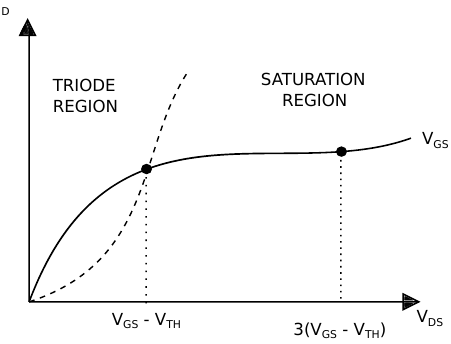
Figure 1. Direct current operating point (DCOP) regions in a MOS transistor plotting I D vs V DS .